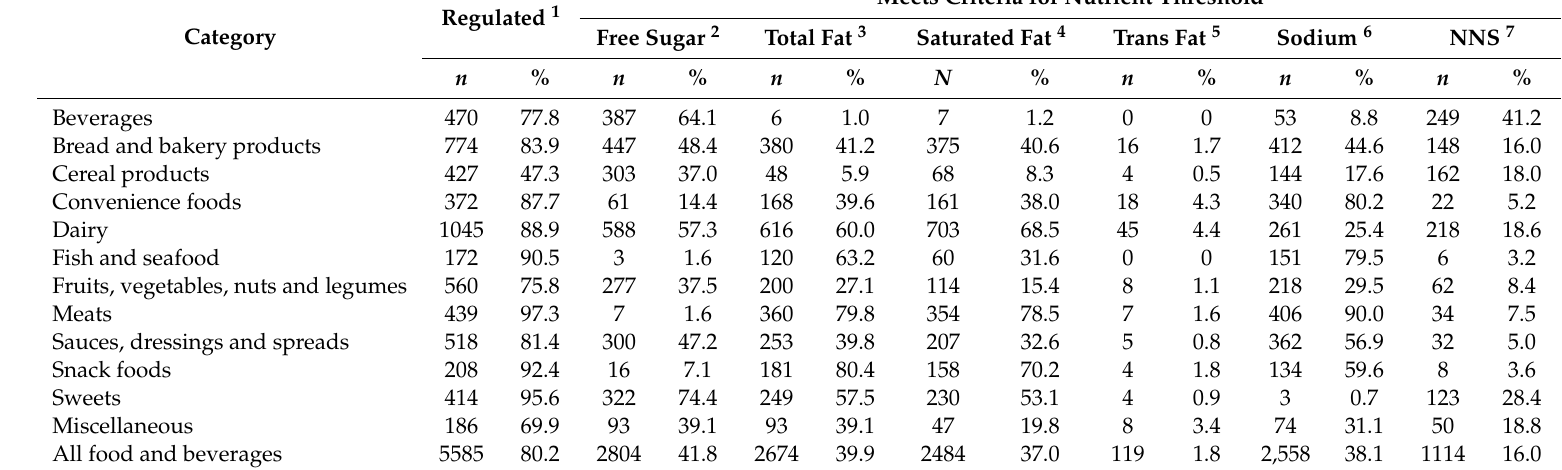
Table 2. Number and proportion of packaged food and beverage products meeting criteria for regulation under the Pan American Health Organization nutrient profile model (PAHO model), by food